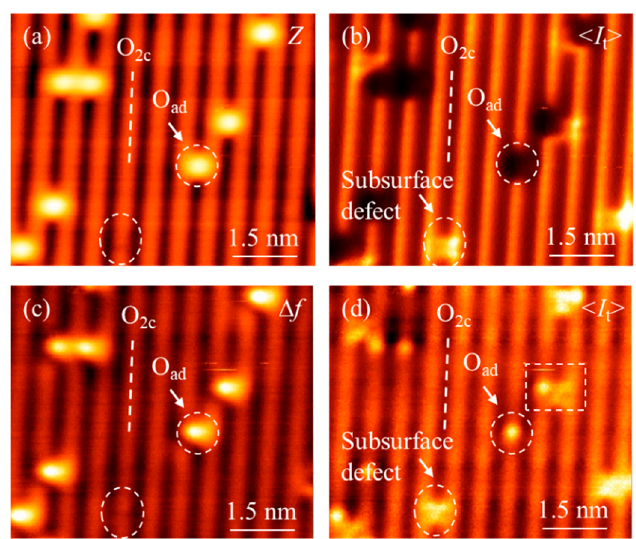
Figure 4. ( a , b ) Topographic and corresponding tunneling current images of O-TiO 2 (110) surface obtained in the constant frequency shift mode. There is crosstalk between topography and < I t > signals and O ad is imaged dark spot in < I t > image. ( c , d ) frequency shift and corresponding tunneling current images of O-TiO 2 (110) surface obtained in the constant height mode. The crosstalk between topography and < I t > signals is eliminated.